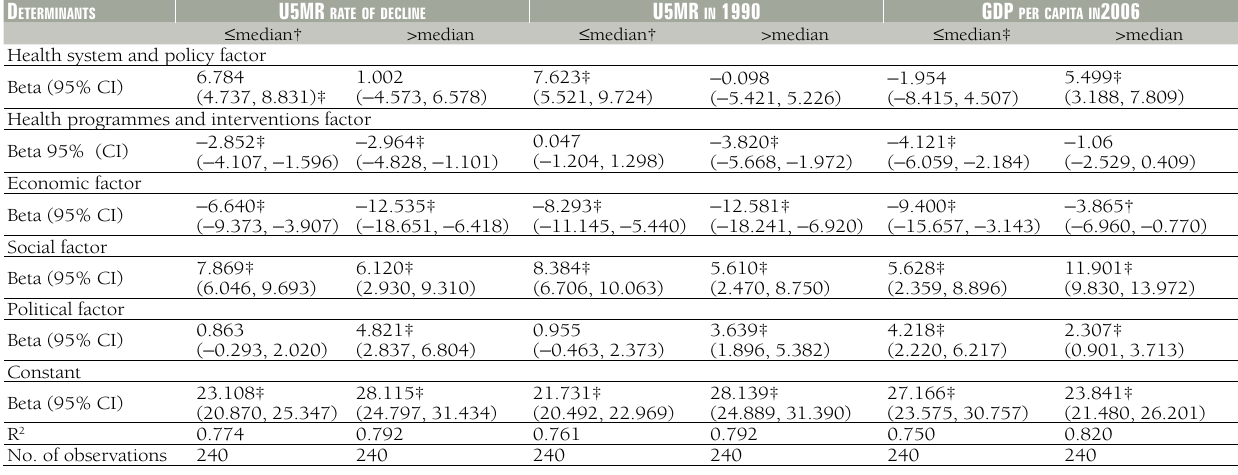
Table 3 Adjusted associations between U5MR and the social, economic, political, health system determinants with 1 year lag after stratifying by U5MR rate of decline, level of U5MR in 1990 and GDP per capita level in 2006 d